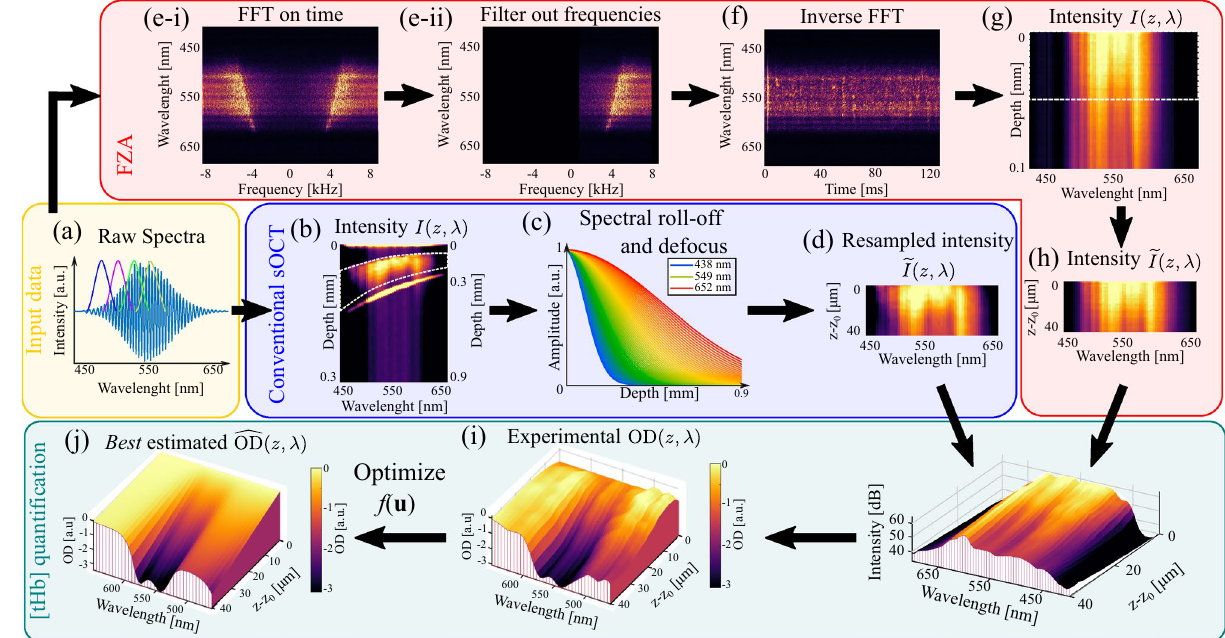
Figure 2. Estimation of [tHb] from sOCT data. (a) Spectra acquired with the sOCT system were processed according to the acquisition scheme: conventional sOCT (blue path (b–d) ) and FZA (red path (e–g) ). For conventional sOCT, spectral analysis (b) retrieved the intensity as a function of depth and wavelength I ( z , (cid:31) ) . We compensated the system roll-off and the defocus, and resampled the intensity (d) within the region I ( z , (cid:31) ) . For FZA, spectra were Fourier transformed into the frequency domain (e-i) , negative of interest frequencies were filtered out (e-ii) , and data was transformed back to the time domain (f) . The spectral analysis yielded the intensity as a function of wavelength and depth (g) . Since the translation stage controlled the optical (cid:31) path length resampling was not required (h) . In both cases, we selected a region of interested of 40 µ m in depth, OD (j) with Eqs. (5) and the experimental OD (i) was calculated with Eq. (2) and numerically estimated (cid:31)